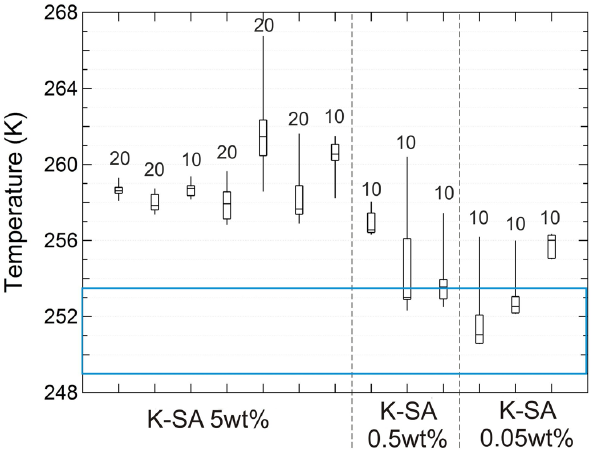
Fig. 9. Box and whisker plot of bulk measurements for K-SA sus- pensions with different concentrations. The blue rectangle repre- sents the spread in pure water freezing temperatures. The numbers on each box represent the number of cycles.